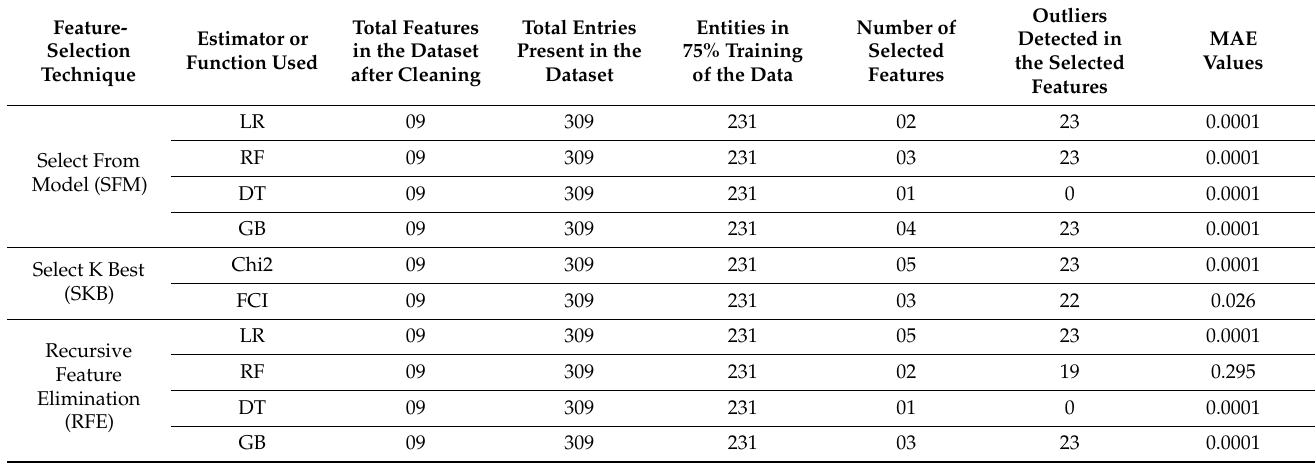
Table 3. Detail of the detected outliers and MAE values in the selected